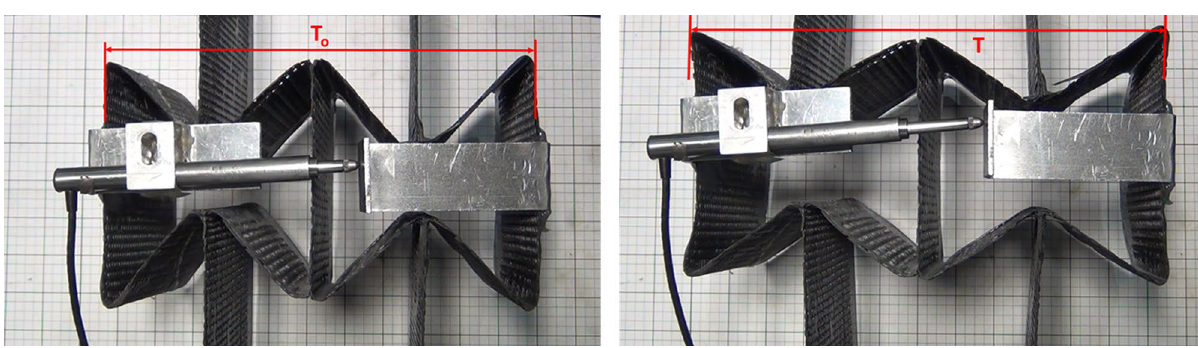
Figure 12. The start (left) and end (right) positions of tensile test for the auxetic